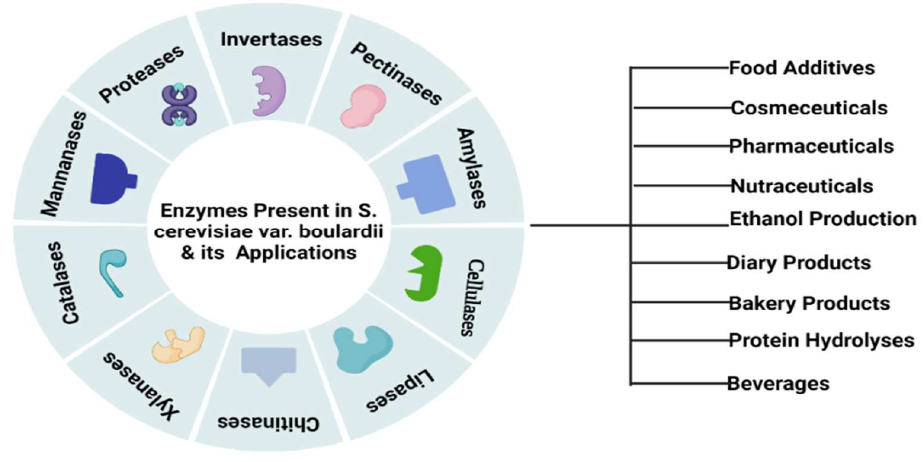
Figure 2. Industrial significance of S. cerevisiae var. boulardii- based